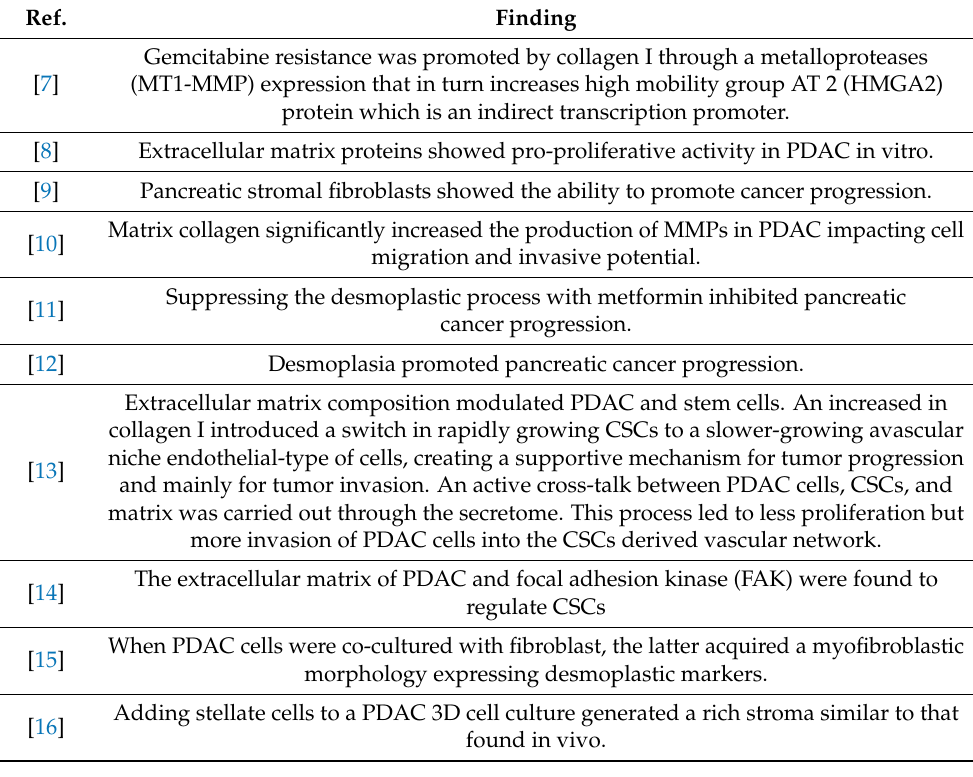
Table 1. Evidence of pro-tumoral effects of the desmoplastic reaction.